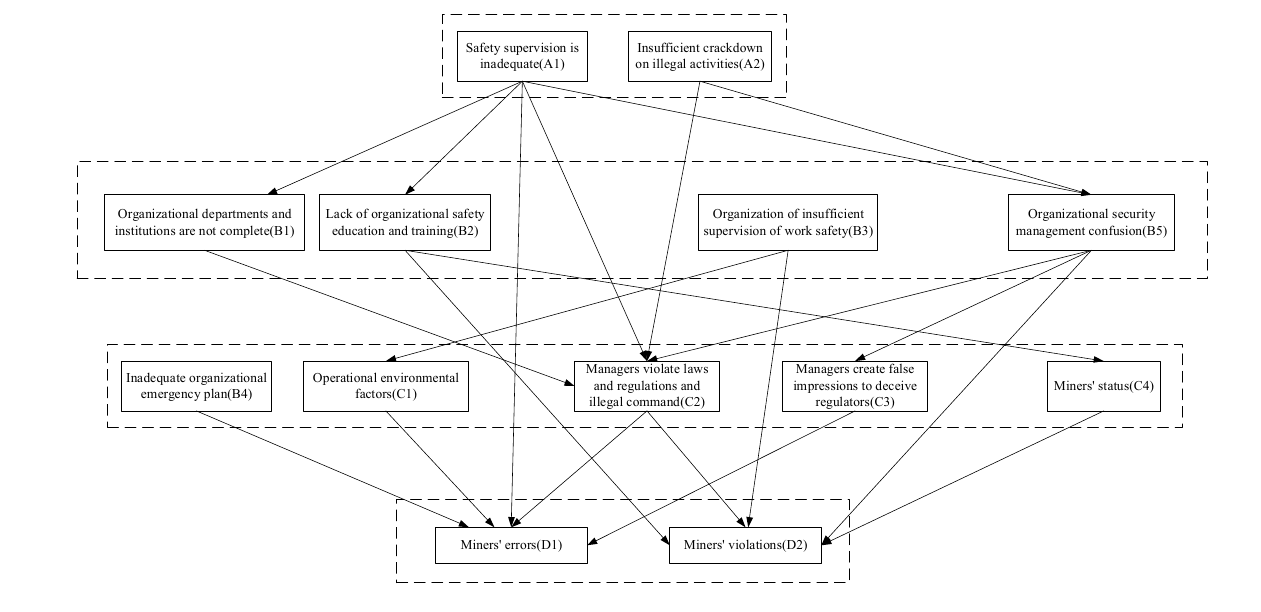
Figure 4. Initial hierarchy.